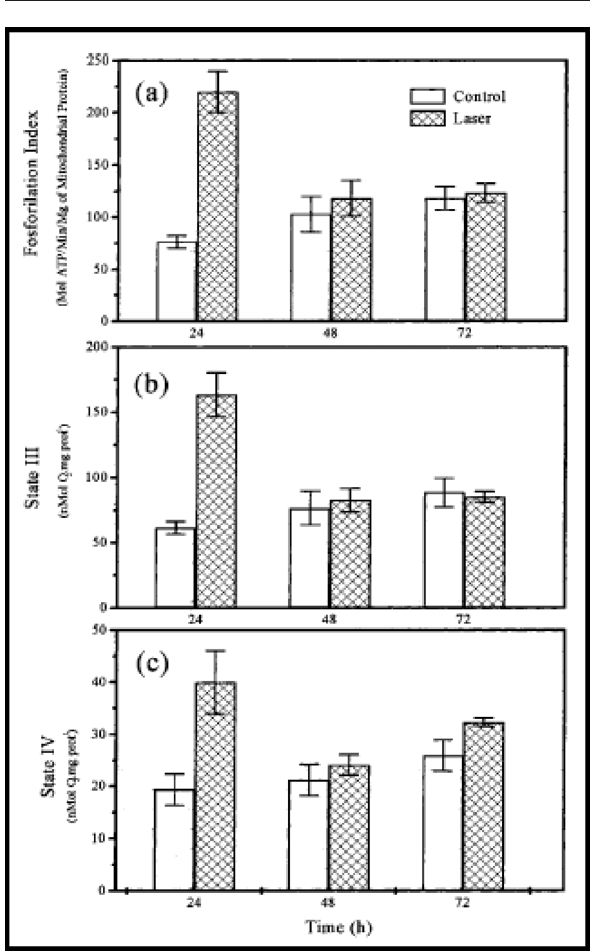
FIGURE 1 - Mitochondrial oxidative and phosphorylative activity measurement. a: Phosphorylation index. b: State III (basal mitochondrial oxygen consumption). c: State IV (mitochondrial activity stimulated